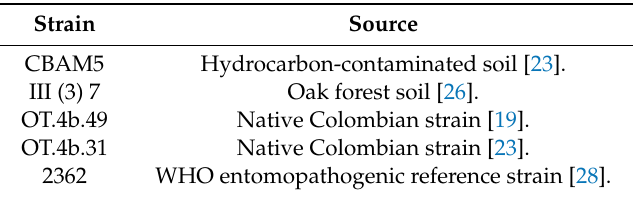
Table 2. L. sphaericus strains used for the mixture.